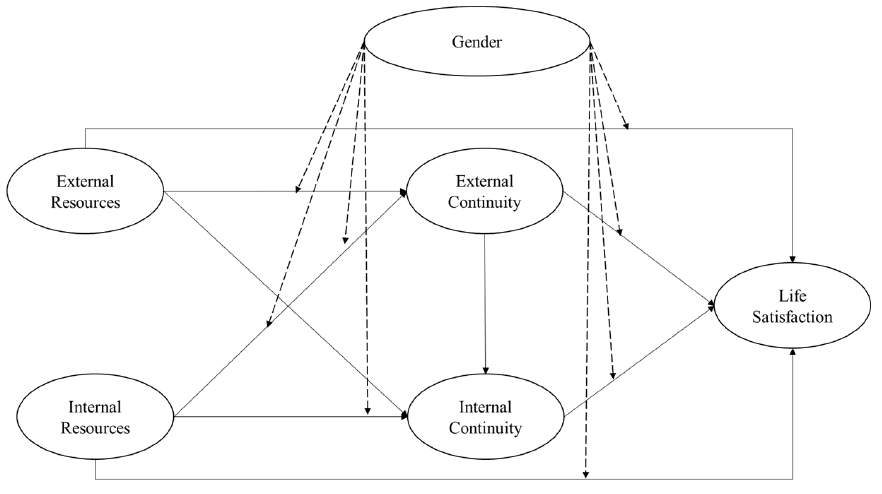
Figure 1. Conceptual Framework Model.